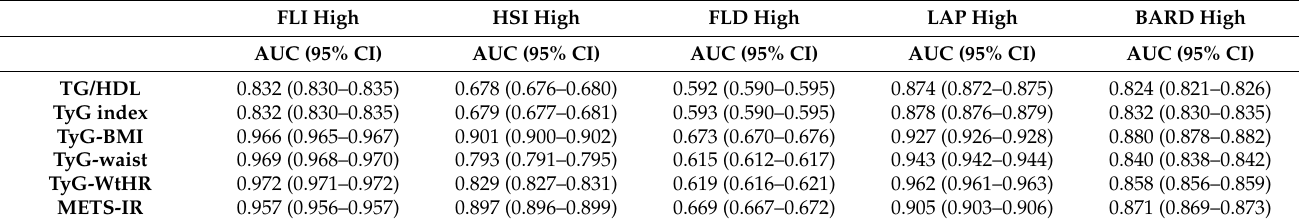
Table 5. Areas under the curve of insulin resistance risk scales to predict the presence of high values of NAFLD and liver fibrosis risk scales.